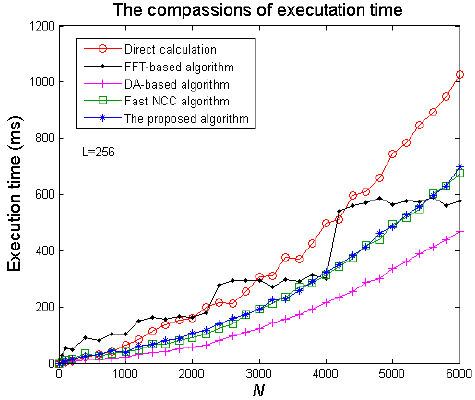
Figure 11. The comparisons of the five algorithm’s execution time (ms).